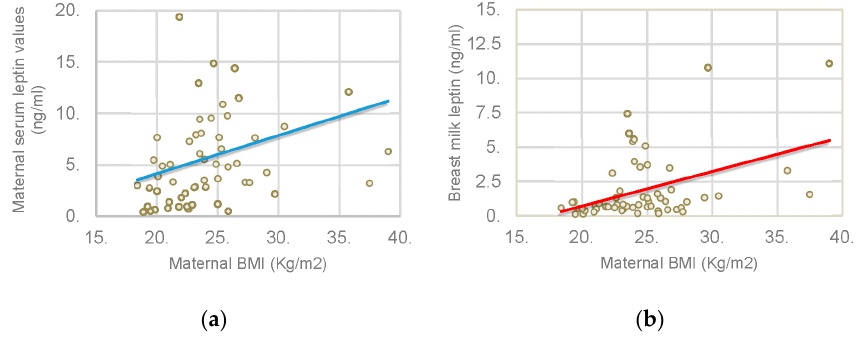
Figure 2. Correlation between maternal BMI and maternal serum leptin and breast milk leptin. ( a ) Association between maternal BMI and maternal serum leptin values; ( b ) Association between maternal BMI and breast milk leptin.